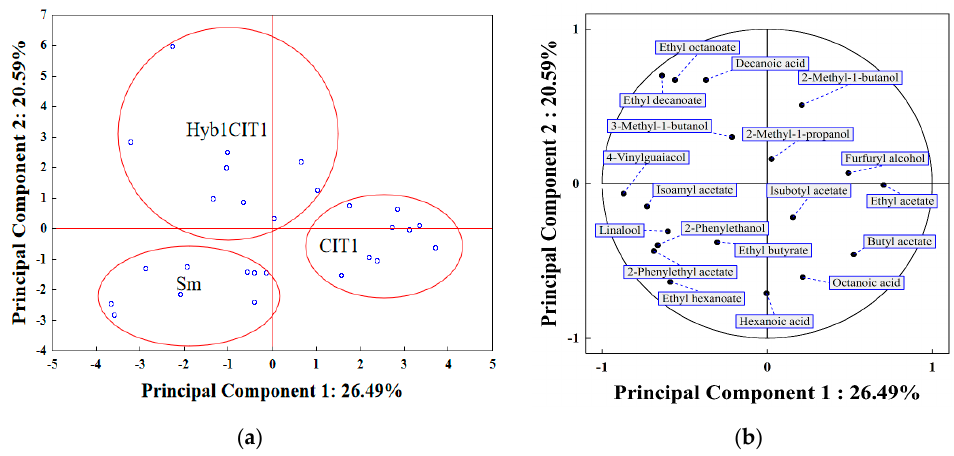
Figure 5. Scatter plot (a) and loading plot (b) of the principal component analysis (PCA) of VOCs profiles of beer samples. Beer sample abbreviations ( Hyb1CIT1 , Sm and CIT1 ) correspond to yeast abbreviations (Table 1) used in beer production.